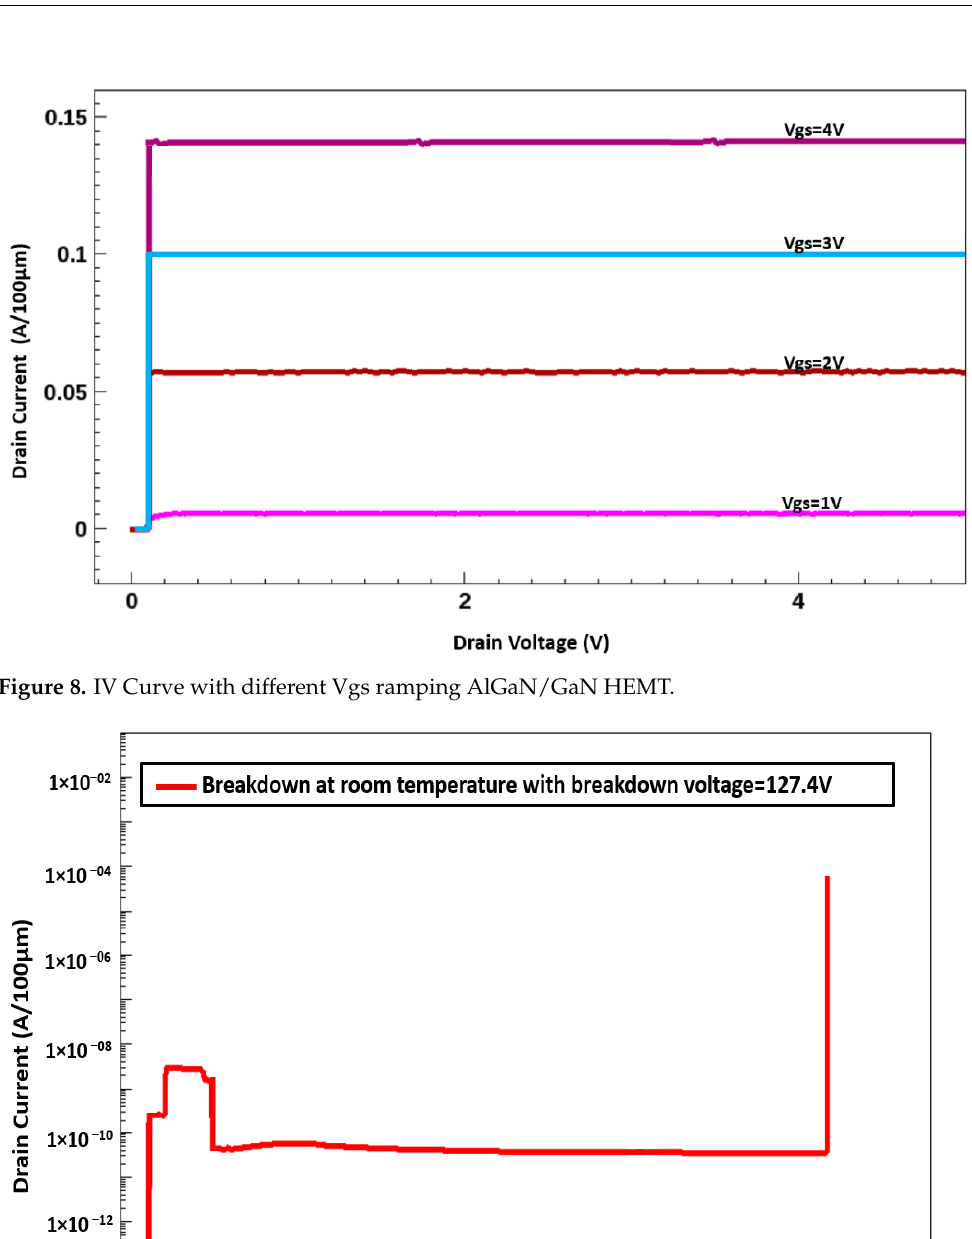
Figure 8. IV Curve with different Vgs ramping AlGaN/GaN HEMT.